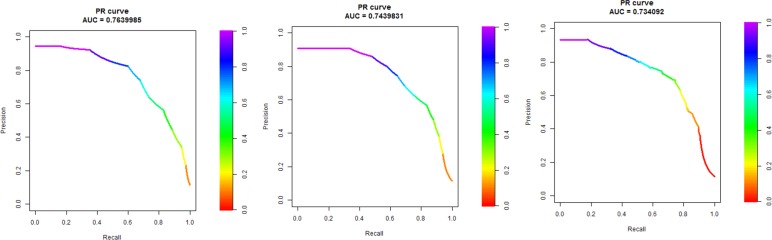
AUPRC curves for the 3 best models.Random Forest (RF) in association with Backward Selection (BS) and 69 features (left), with Forward Selection (FS) and 8 features (middle) and Gini Selection (GS) and 5 features.